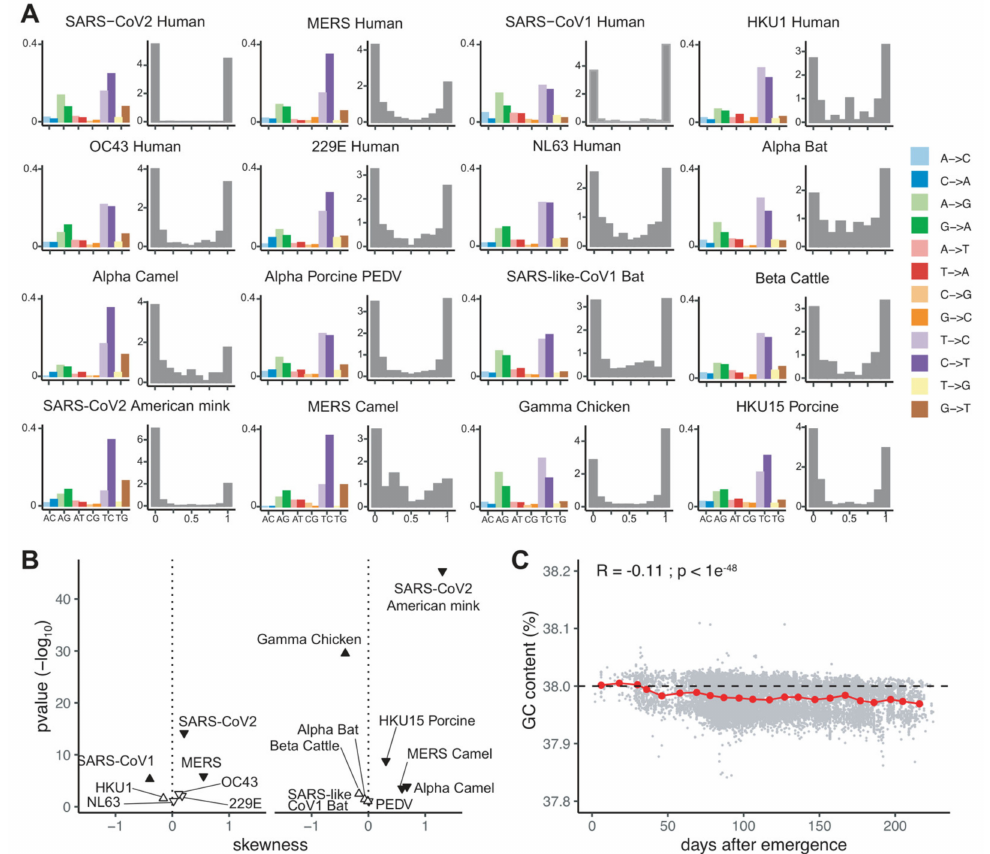
Figure 2. Mutational bias and equilibrium among endemic and recently zoonotic coronaviruses. ( A ) (left side of each panel) Relative substitution rates for all twelve transition and transversion events, calculated from the total number of SNPs called on the synonymous compartment of a metapopulation composed by all available sequences of the corresponding virus, curated, filtered and aligned. In the x axis, for each of the nucleotide pairs indicated, the frequency of the two substitutions are indicated, e.g.,: A->G in light green and G->A in dark green for the AG pair, or T->C in light purple and C->T in dark purple for the TC pair. (right side of each panel) Folded Site Frequency Spectrum (SFS) of G/C-to-A/T substitutions. For each viral metapopulation, the frequencies of SNPs involving a change in GC content called are plotted, the x -axis progressing from GC-enriching to AT-enriching substitutions. ( B ) Volcano plot of the folded SFS skewness values presented in ( A ), plotted against the probability that such a value could have been obtained if the corresponding metapopulation were at its mutational equilibrium. The left panel displays CoVs infecting humans while the right panel displays CoVs infecting other mammalian hosts. Downward and upward triangles, respectively, refer to SFS-negative and SFS-positive skewness values. Filled triangles indicate metapopulations with a skewness significantly different from the expected one at mutational equilibrium. ( C ) Temporal evolution of the SARS-CoV-2 GC-content in the coding genome during the spread of the pandemic. The GC-content of each individual SARS-CoV-2 genome is represented by a gray dot. Red dots represent the average GC-content by time window of 10 days. The results of a Pearson correlation test of GC content over time for the complete data set (n = 81,963) are displayed in the